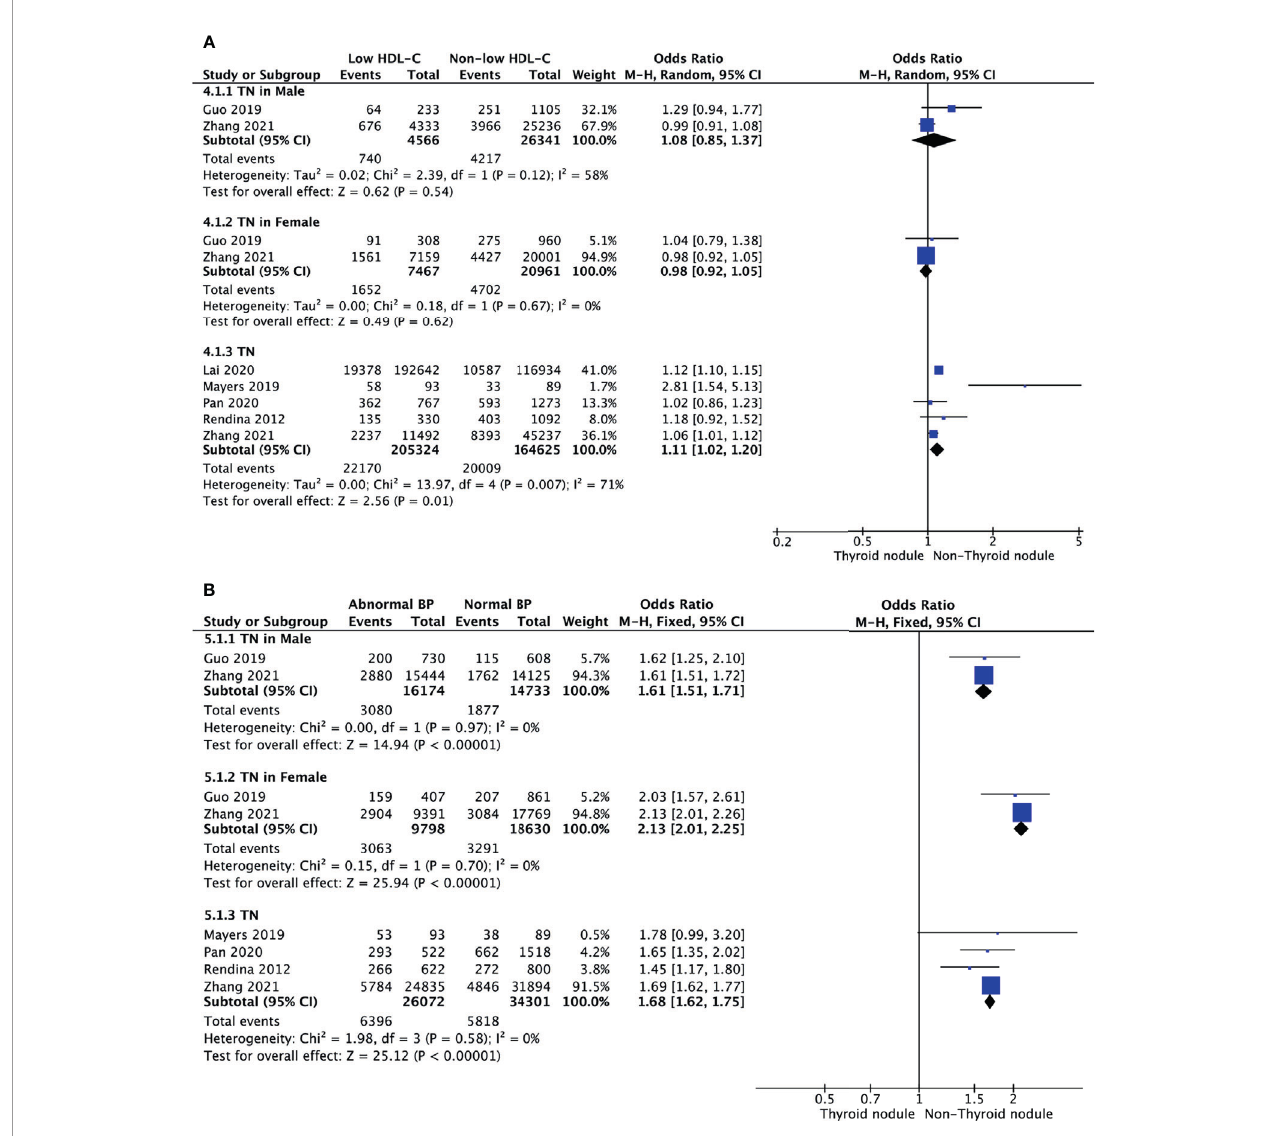
FIGURE 4 | Forest plots of the association among low HDL-C (A) , abnormal BP (B) , and